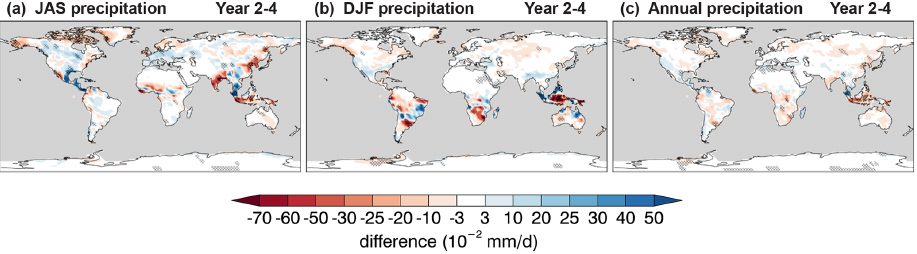
Figure 14. The impact of volcanic aerosols on mean precipitation forecasts. Difference of (a) summer (July–August–September), (b) winter (December–January–February), and (c) annual mean Year 2–4 precipitation forecasts with and without volcanic eruptions. Computations include 10-member ensembles of forecasts with and without eruptions of Mount Agung, El Chichón, and Mount Pinatubo as per the DCPP Component C volcanic experiment setup (Boer et al., 2016). Cross-hatched regions indicate values significantly different from zero at the 90% confidence